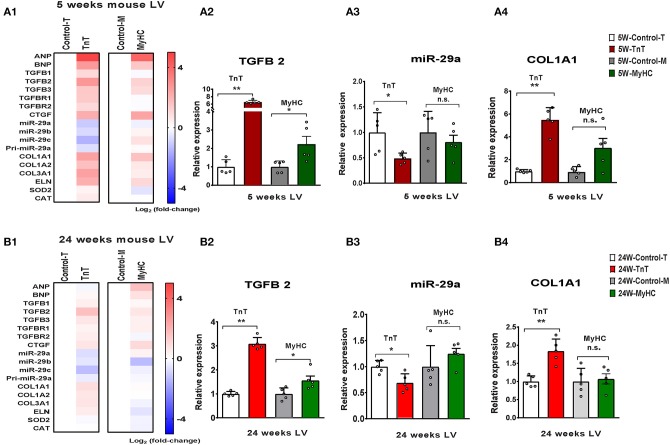
Allele-specific differences in expression of miR-29 family and pro-fibrotic genes in left ventricle of HCM mice at 5 and 24 weeks of age. (A1) Heat map summarizing expression data for miR-29a/b/c, select profibrotic and redox genes in the LV of TnT and MyHC mutant mice and respective littermate controls at 5 weeks of age. Expression of miR-29 family is significantly lower and profibrotic genes in significantly higher only in TnT mutant-LV when compared to littermate control-LV at 5 weeks of age. Differentially-expressed genes are shown in graduated red (upregulated) or blue (downregulated) based on their log2 fold-change compared to respective littermate controls. (A2–4) Summary for expression of TGFB2, miR-29a, and Col1A1 in LV of TnT and MyHC mutants, and respective littermate controls at 5 weeks of age shows greater upregulation of TGFB2 in TnT mutant-LV than MyHC mutant-LV, when compared to respective littermate control-LV. miR-29a suppression and increase in COLl1A1 expression was only observed in TnT mutant-LV (linear fold change is presented). (B1) Heat map summarizing expression data for miR-29a/b/c, select pro-fibrotic and redox genes in LV of TnT and MyHC mutant mice and respective littermate controls at 24 weeks of age. Only TnT mutant-LV demonstrate downregulation of miR-29 family at 24 weeks of age. Differentially expressed genes are shown in graduated red (upregulated) or blue (downregulated) based on their log2 fold change compared to respective littermate controls. (B2–4) Summary for expression of TGFB2, miR-29a, and COL1A1 in LV of TnT and MyHC mutant mice, and respective littermate controls at 24 weeks of age shows greater upregulation of TGFB2 in TnT mutant-LV than MyHC mutant-LV, when compared to respective littermate controls. Expression of miR-29a/b/c is lower and COL1A1 gene expression is higher in TnT mutant-LV, but not MyHC mutant-LV when compared to respective littermate controls (linear fold change is presented) (control-T, TnT-littermate control; TnT, TnT-mutant; Control-M, MyHC-littermate control; MyHC, MyHC-mutant). Data are expressed as mean ± S.D.; n = 5 in each group. The two-tailed unpaired Student's t-test was used to compare TnT mutants and MyHC mutants with respective littermate controls; **P < 0.01; *P < 0.05; n.s., non-significant).